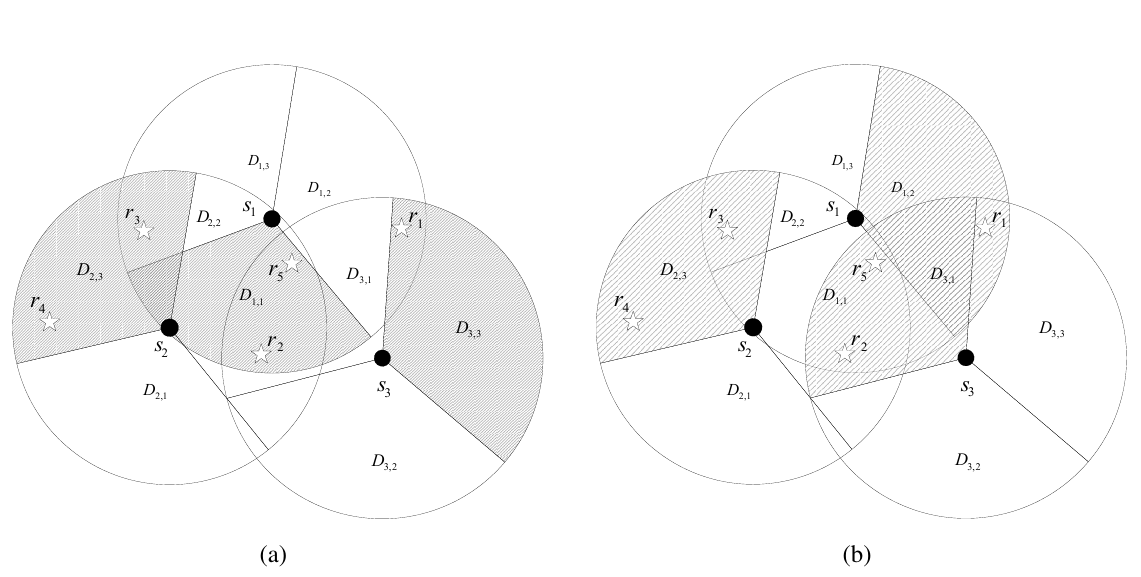
Illustrative example of a directional sensor